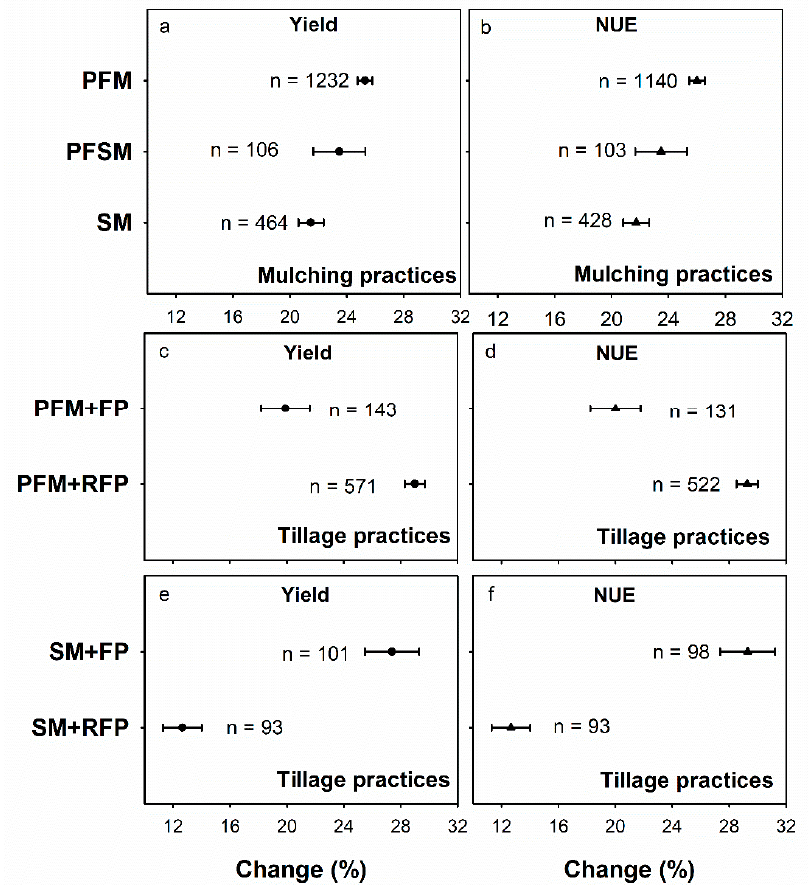
Figure 4. Response of change in potato yield ( a , c , e ) and NUE ( b , d , f ) to mulching compared to no mulching with different mulching and tillage practices. Error bars represent 95% confidence intervals. The values for n represent the corresponding number of observations. PFM, plastic film mulching; SM, straw mulching; PFSM, combination of plastic film and straw mulching; FP, flat plots; RFP, ridge-furrow plots.